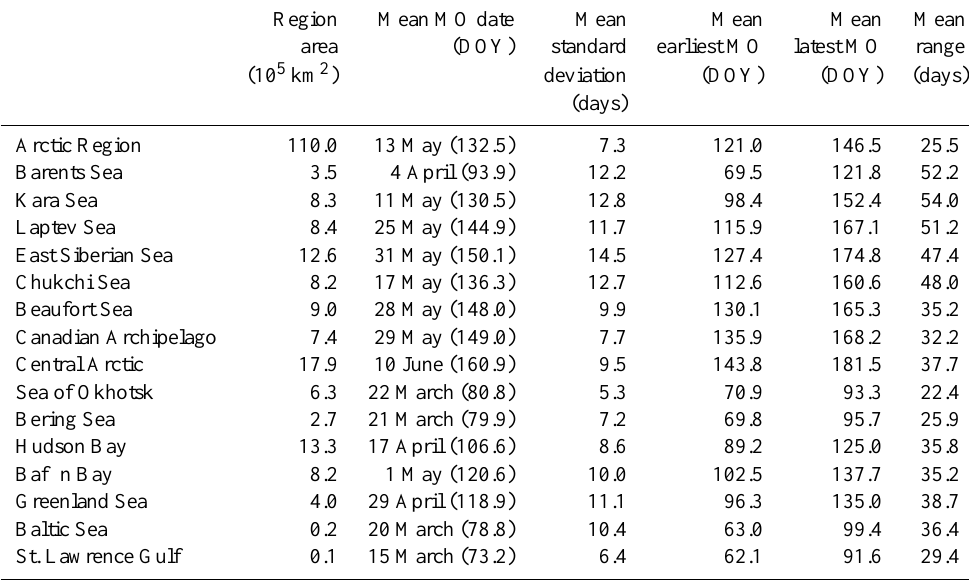
Table 1. Mean regional melt onset date statistics for 1979–2012.